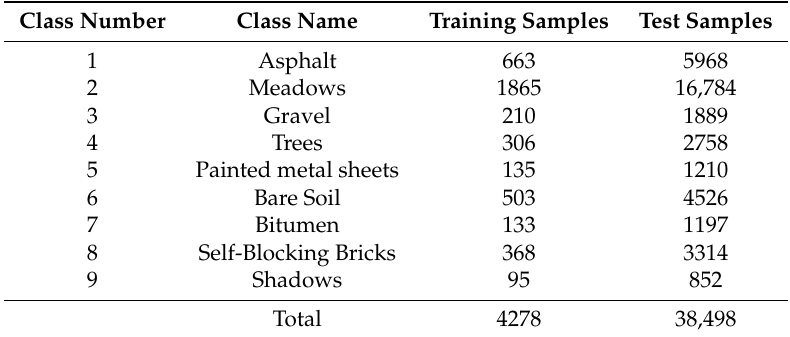
Table 2. University of Pavia dataset: Number of training and test samples.